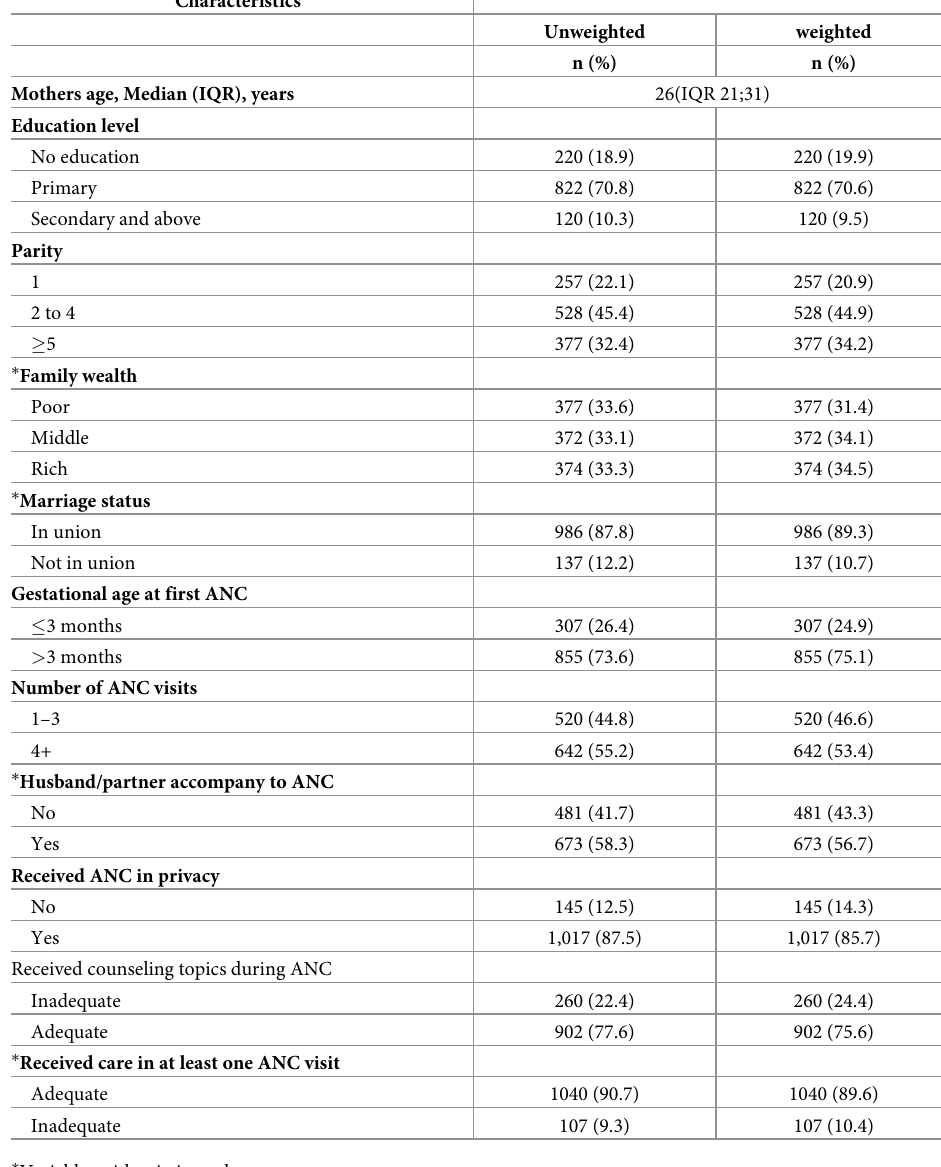
Table 1. Characteristics of women who had at least one ANC visit in Kagera and Mara regions, Tanzania (n = 1,162). Characteristics